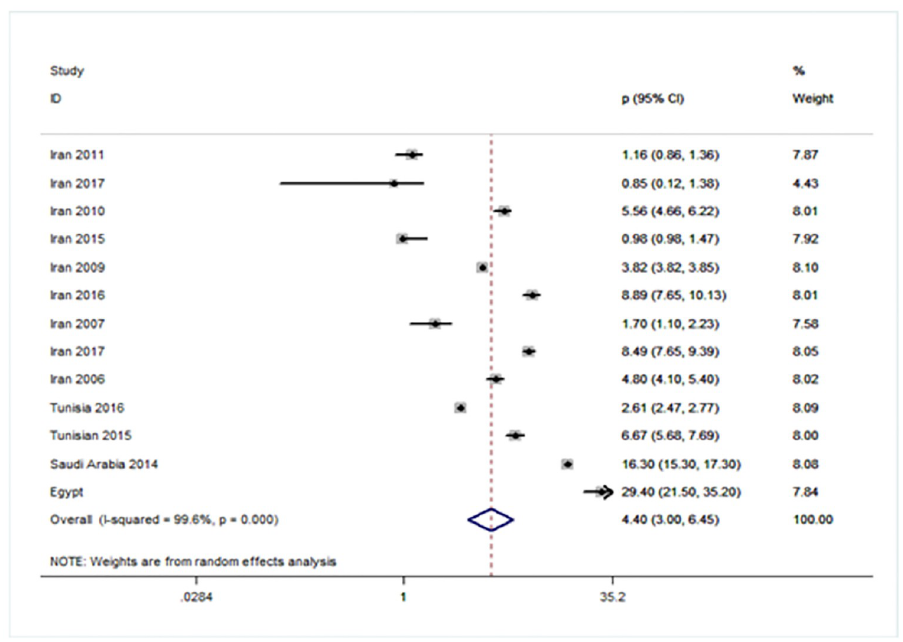
Fig 7. Forest plot showing prevalence of refractive errors among children aged < 20 years in Eastern Mediterranean region.